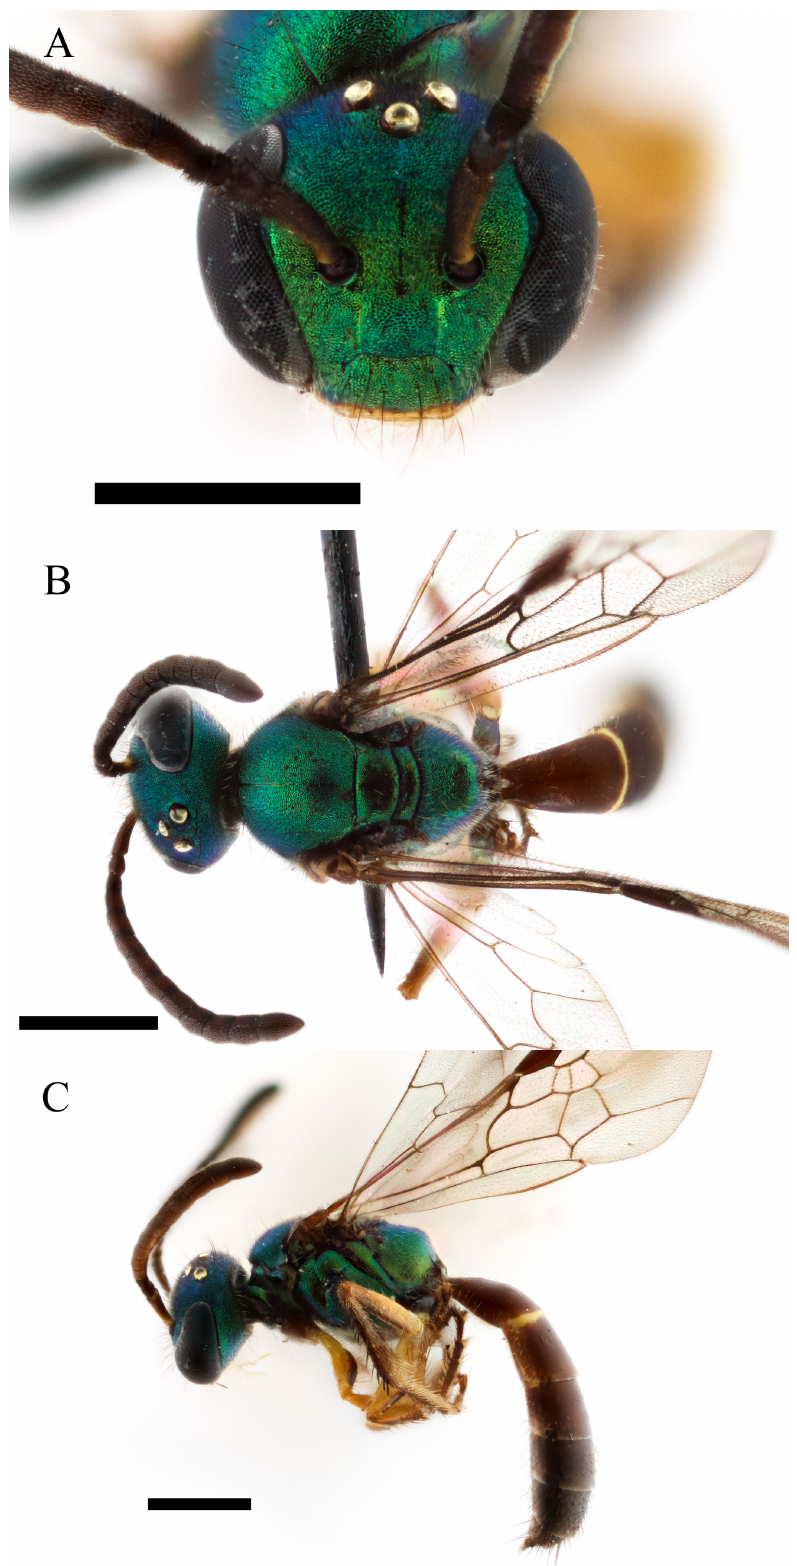
Fig. 18. Habralictus antillarus sp. nov. Holotype, ♂. A . Face. B . Lateral habitus. C . Dorsum of mesosoma. Scale bars = 1